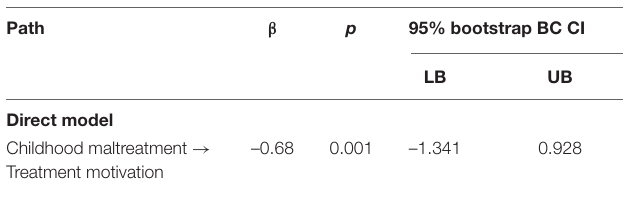
TABLE 4 | Results of the direct